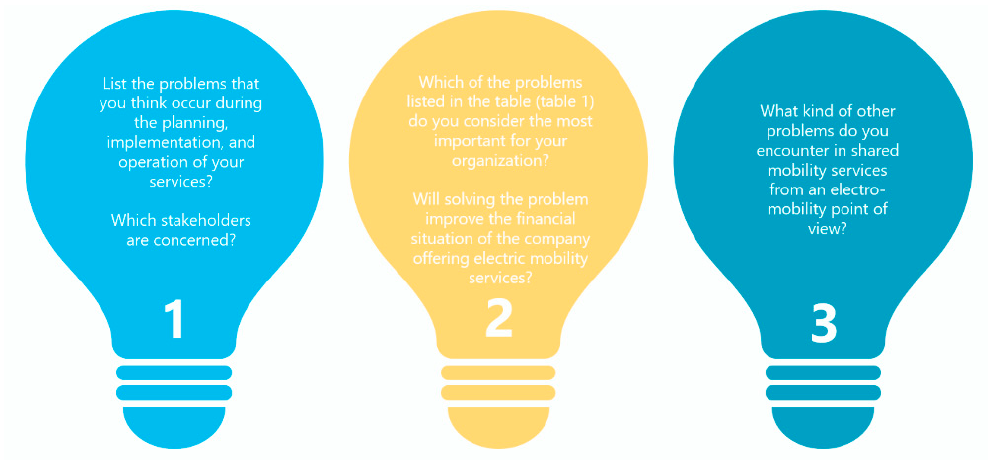
Figure 2. The specific content of the research questions asked during the expert analysis.